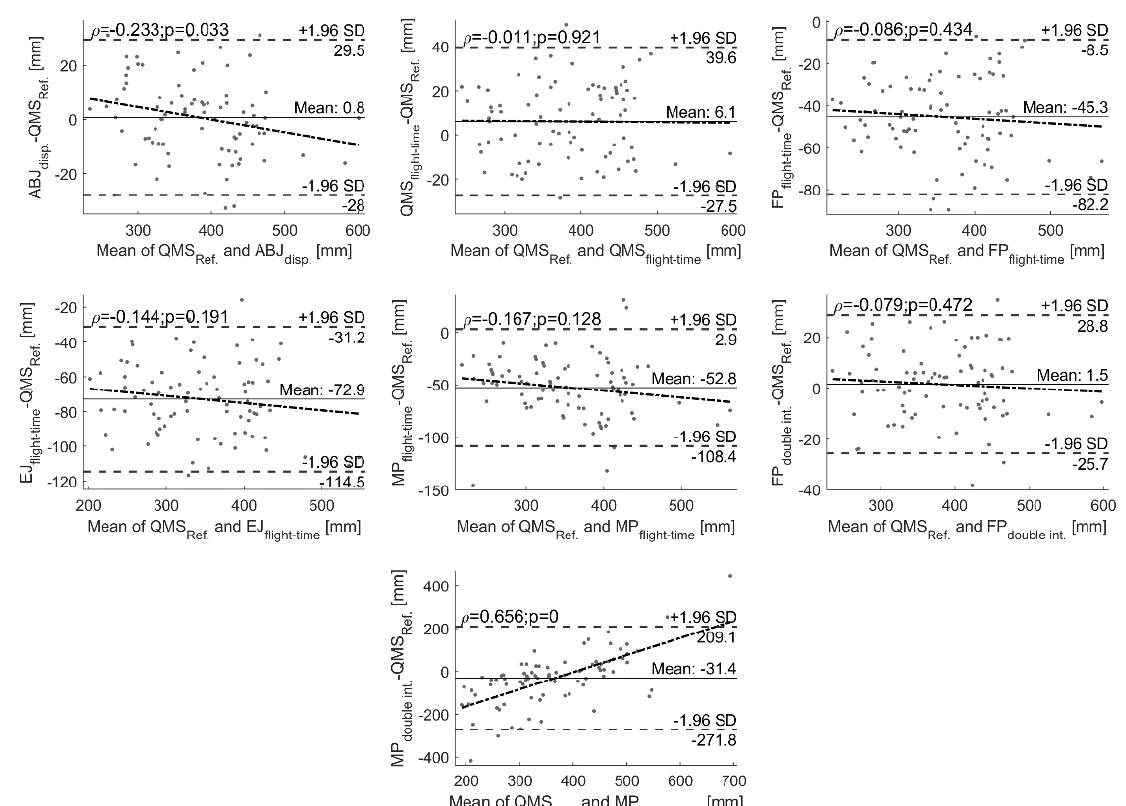
Figure 4. The Bland-Altman plots of the jump height, obtained from different devices and methods. The linear regression line is also shown to investigate the presence of proportional bias. Except for the QMS: flight-time, we observed a significant slope. The Pearson correlation coefficient ( ρ ) and the p-value of the mean variable are also shown. The correlation coefficient revealed a negligible correlation for QMS: flight-time, a moderate